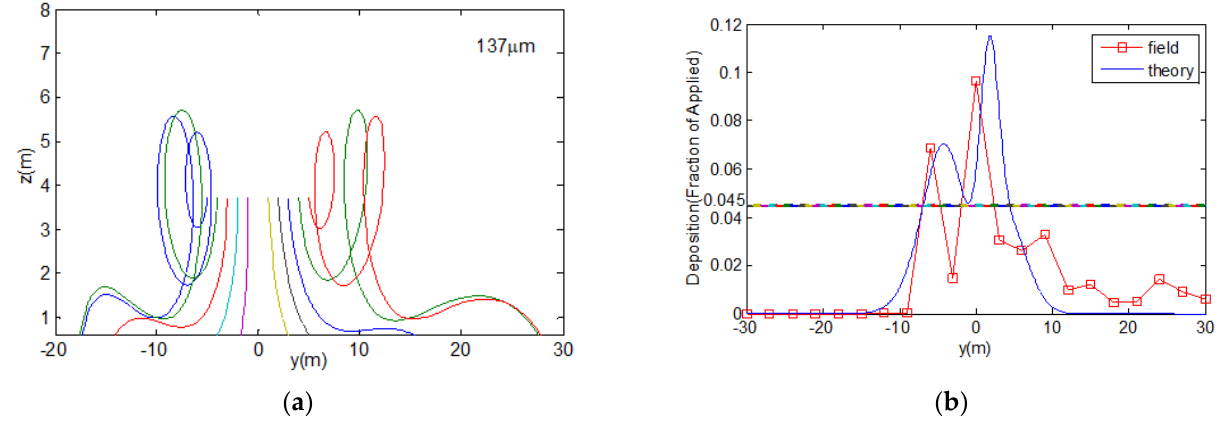
Figure 21. Spray dispersion of Thrush 510G under the effect of headwind: ( a ) trajectories of typical droplets with size 137 μ m; ( b ) ground deposition predicted by IGE model (labeled as “theory”) is compared to sampling data (labeled as “field”) by field experiment [2].